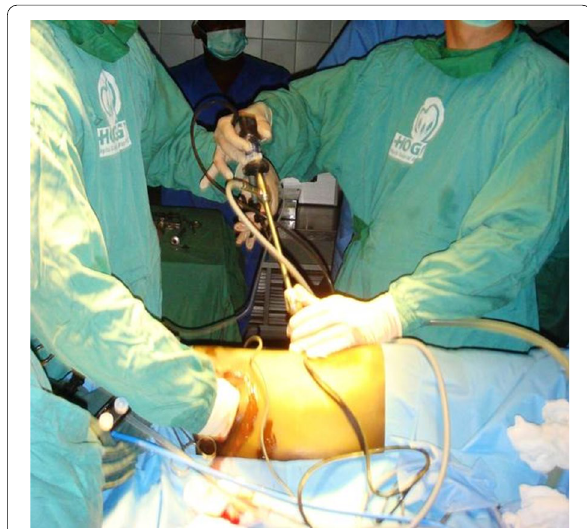
Fig. 4 Hand extraction prior to vessel clipping of a simple nephrectomy similar to donor nephrectomy is excellent training for donor nephrectomy. This operation by the two surgeons was part of the knowledge transfer process and was in Dakar, Senegal, as part of a